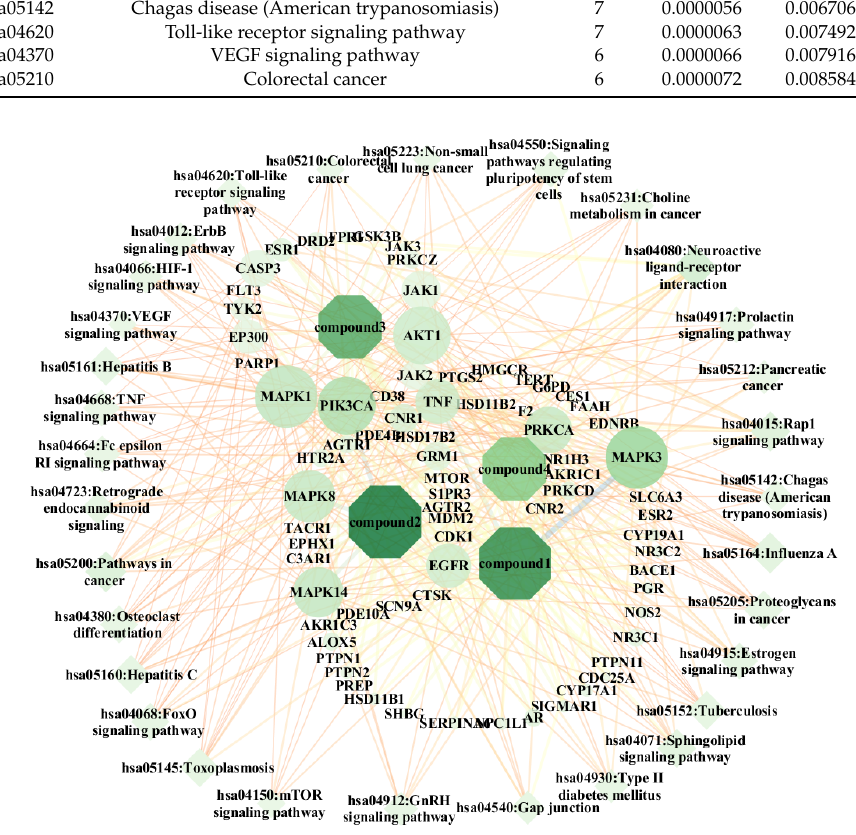
Figure 6. Bioactive component-target-pathway (octagons represent bioactive components, ellipses represent targets, diamonds represent pathways and nodes represent compounds, targets, and pathways; edges represent the interaction of compound-targets, targe- pathways).